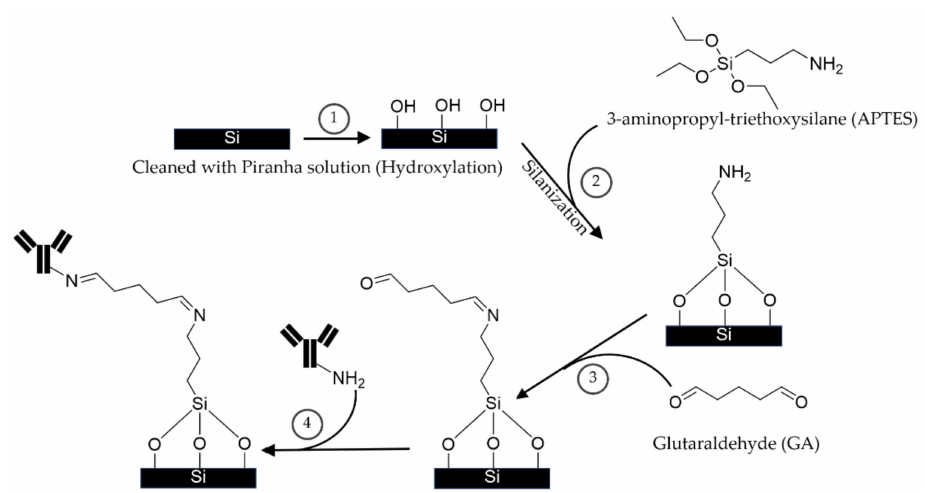
Figure 1. The procedure for the conventional APTES-GA coating.